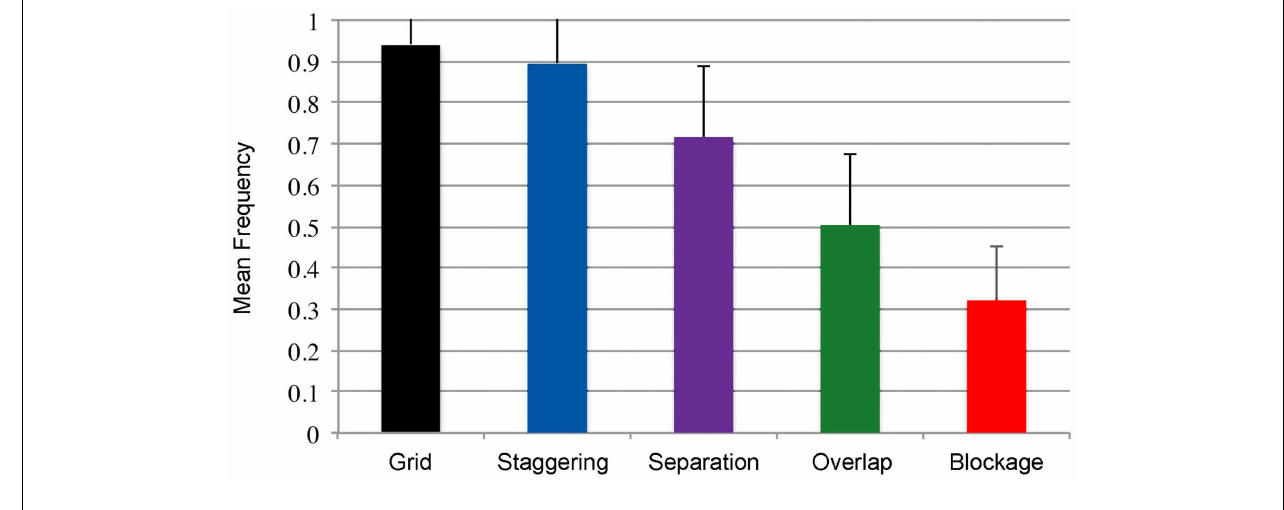
FIGURE 4 | Frequency of using the Z-path under various manipulations.